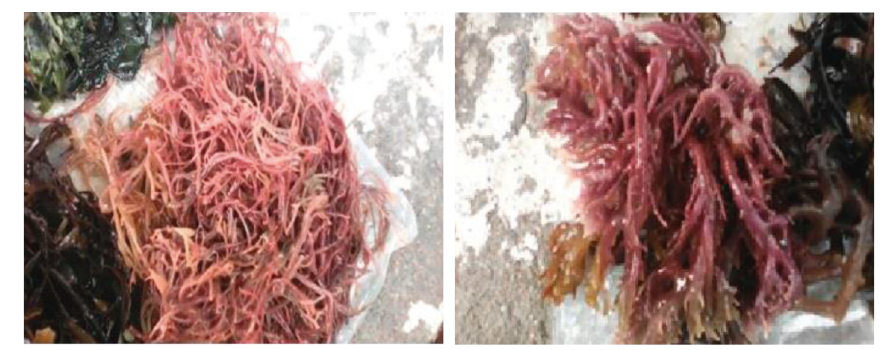
Figure 2: Red algae.